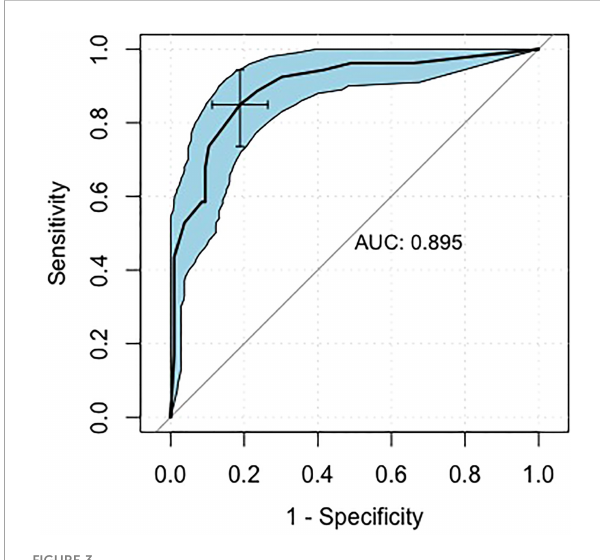
FIGURE 2 CT-based preoperative nomogram for dMMR risk prediction in GC patients.